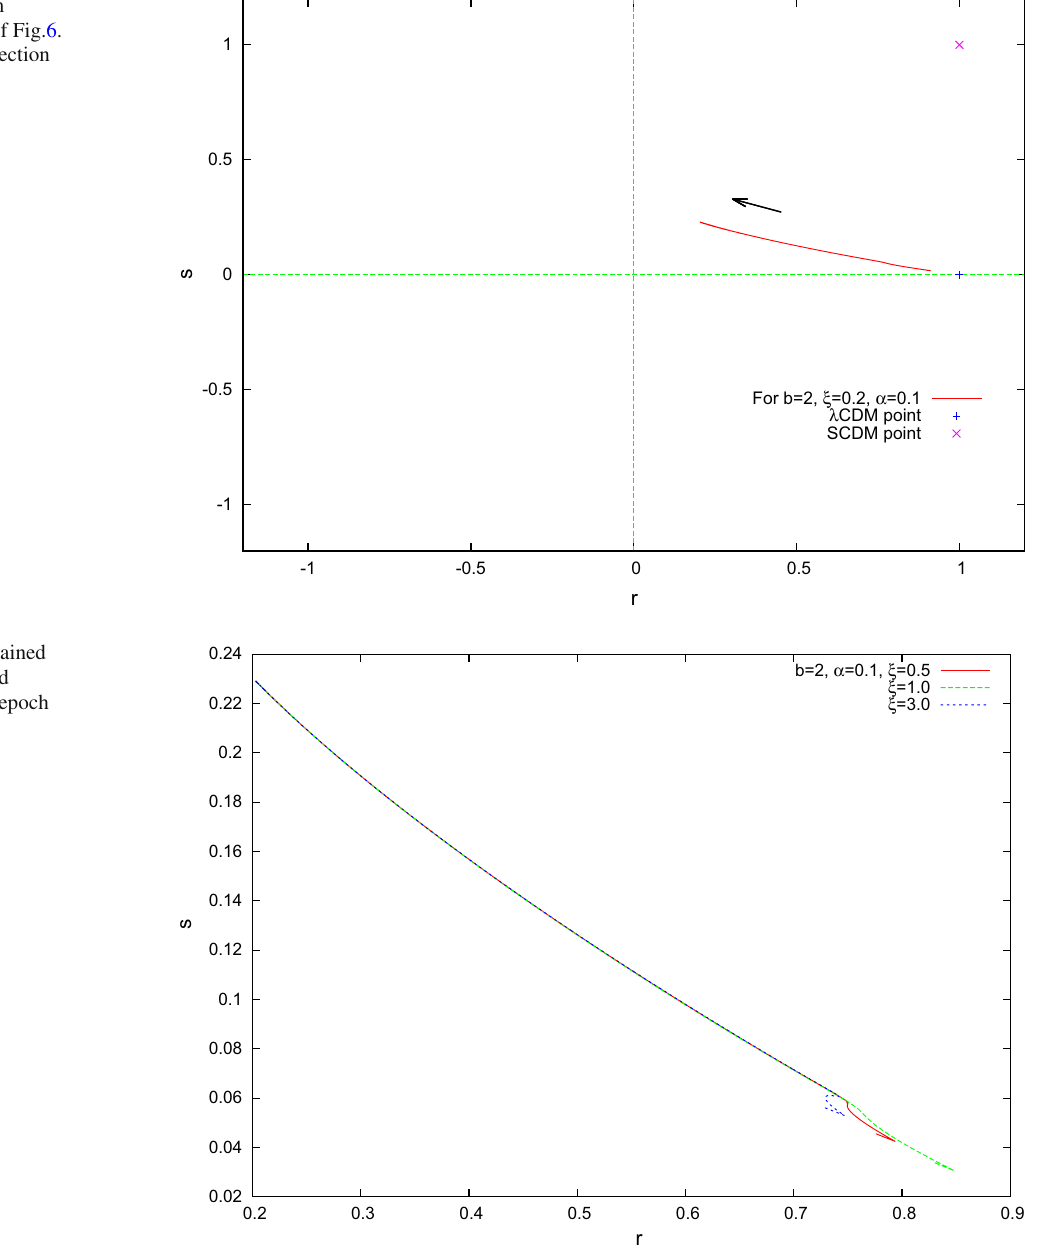
Fig. 7 The r – s diagram obtained from the data of Fig.6. The arrow shows the direction of evolution